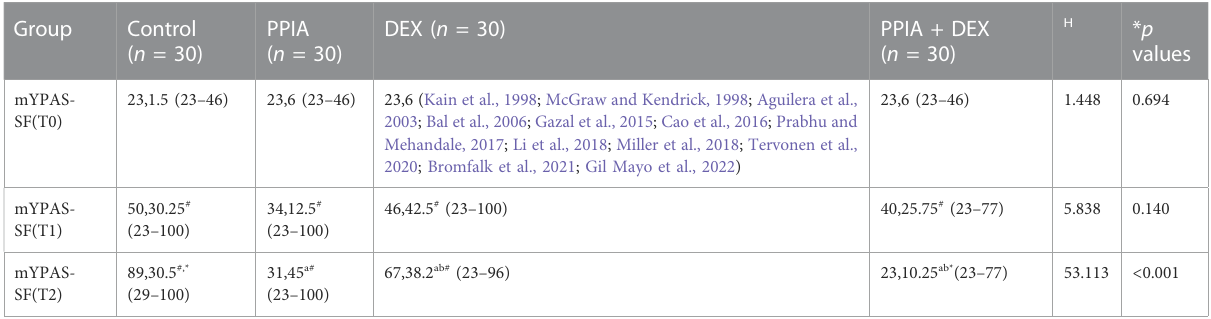
TABLE 2 Primary outcome measures.